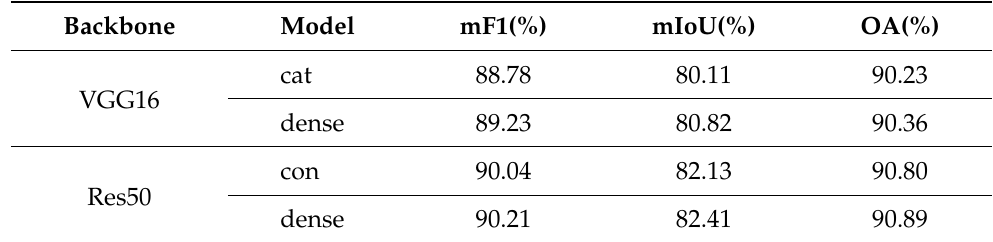
Table 5. Comparison of the method of concatenation (cat) and dense connection (dense) in Vaihin- gen dataset.